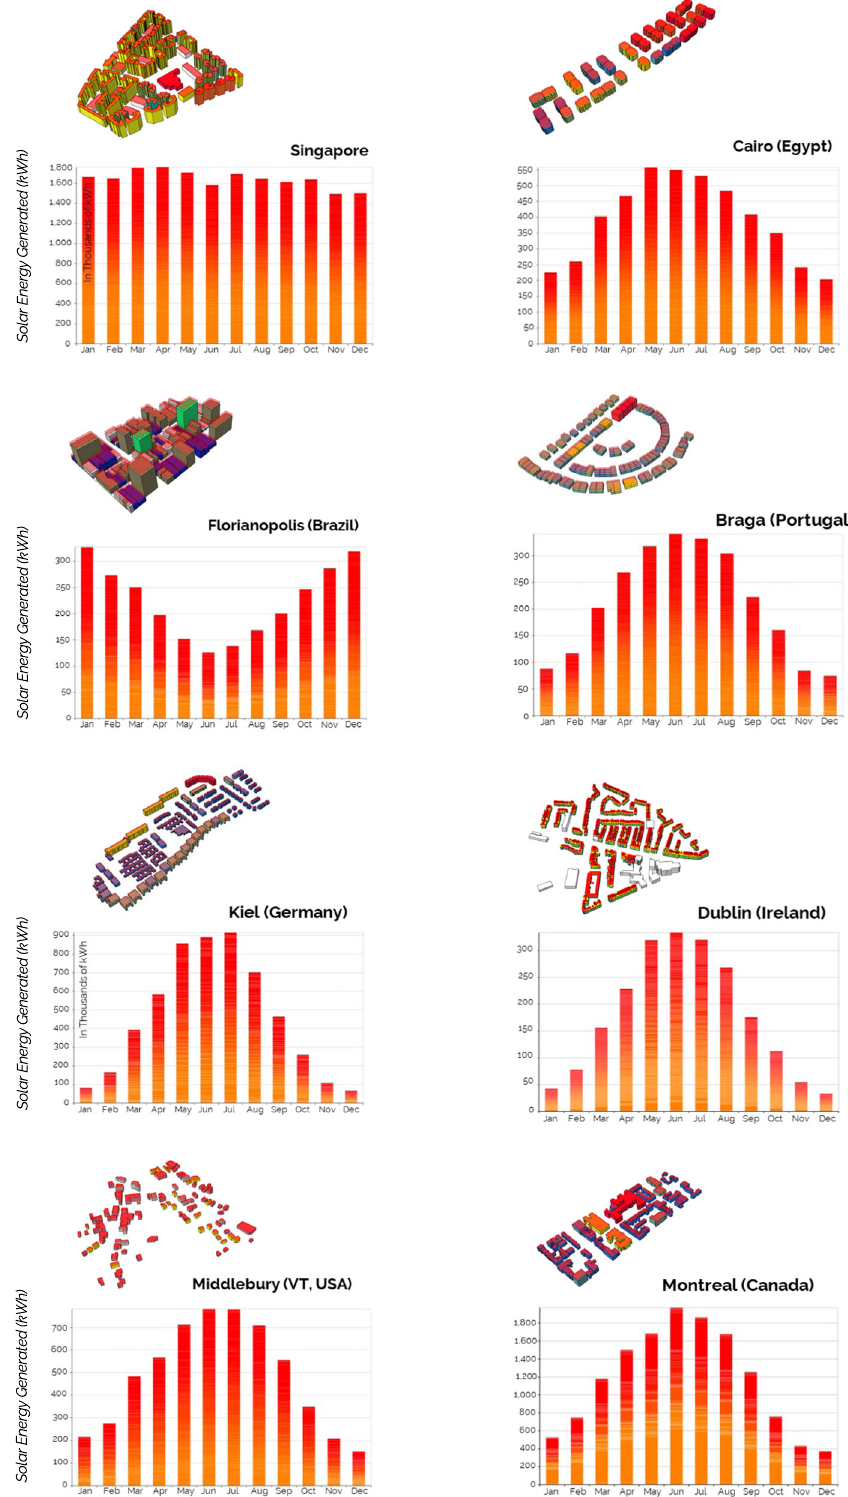
Fig. 5 | Solar energy analysis for the eight cities and annual solar energy yield. Toanalyzesolarenergypotential,wedesignedacustomvisualprogrammingscript in the Rhinoceros3D CAD and Grasshopper visual programming/scripting envir- onment. Speci fi cally, our script extrudes rooftop areas as horizontal surfaces with surface normal pointing in the direction of the z-axis. Based on the areas, the